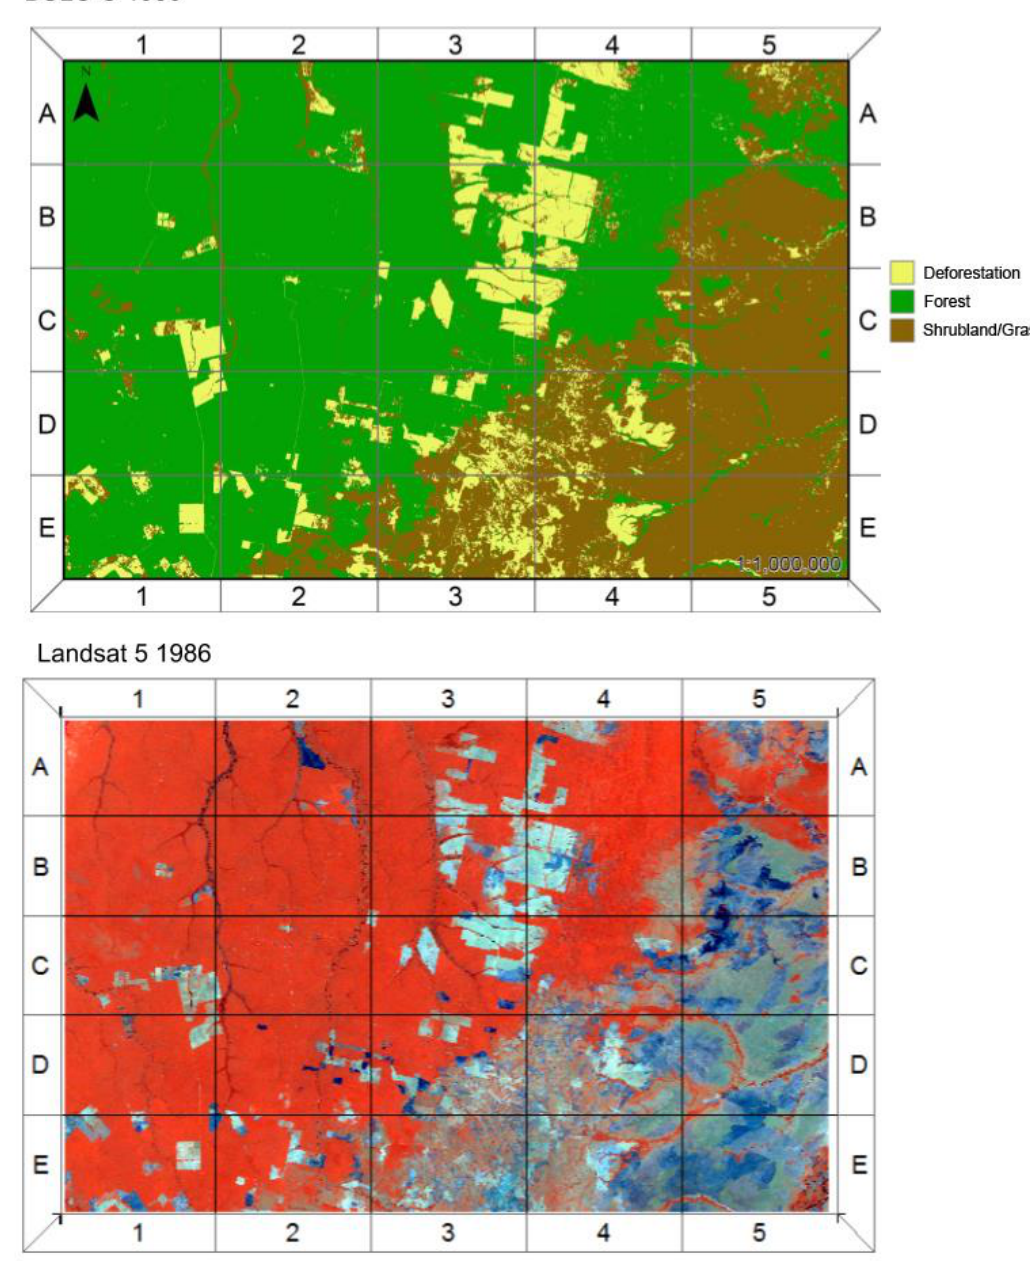
Figure 4. Land use and land cover (LULC) at beginning of study period. BULC-U 1986 classification (above) and raw Landsat 5 image of 1986 (below).